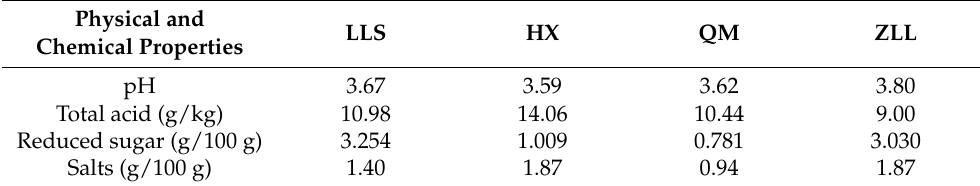
Table 2. Physicochemical properties of